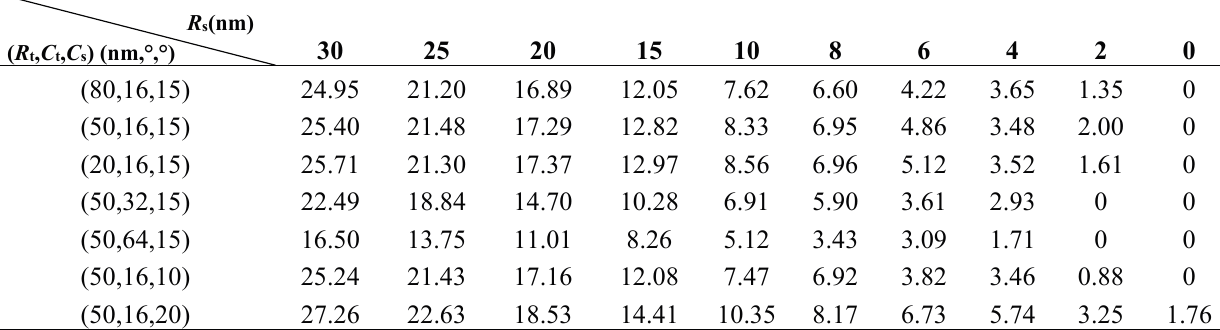
Table 2. The errors of the BTR of different tips and samples. For example, on row of (80, 16, 15), it shows how the errors change with the radius of curvature of samples when the radius of curvature of tip is 80nm, the cone angle of tip is 16° and the cone angle of sample is